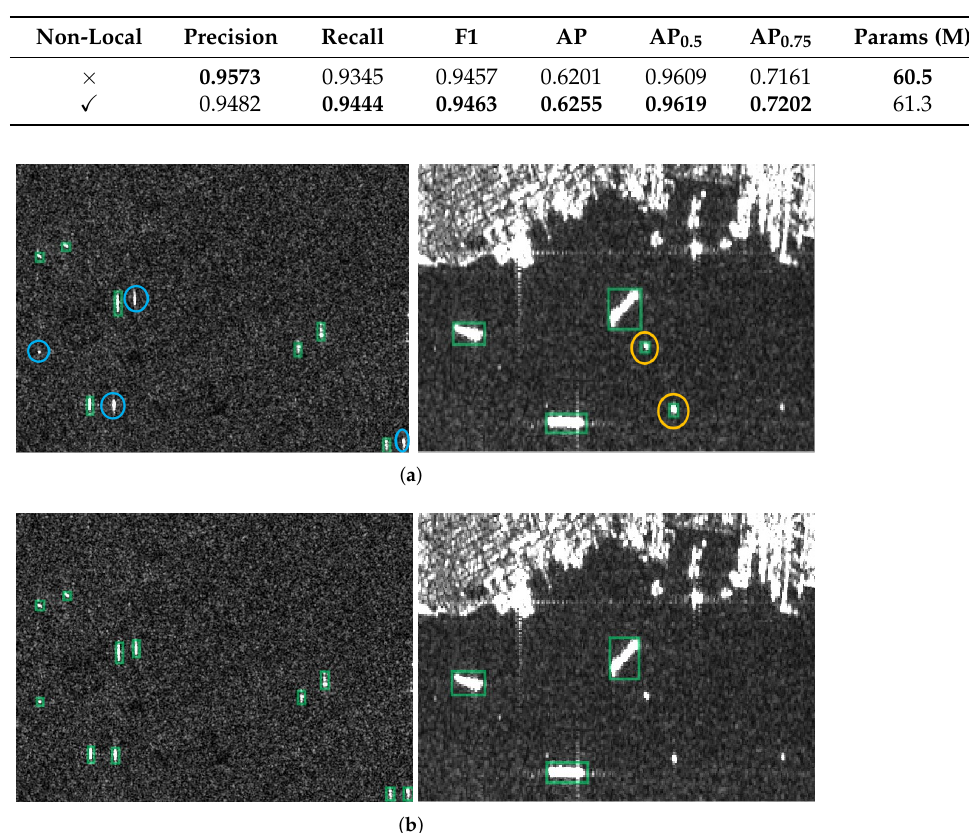
Table 6. Effectiveness of the non-local network in WCFF module.